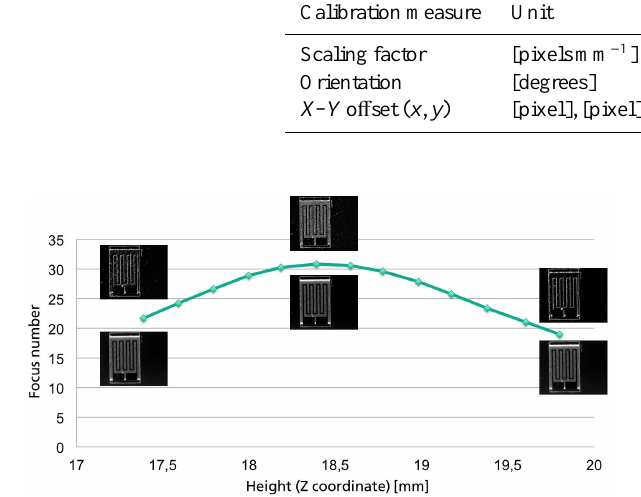
Figure 14. The plot shows a single measurement run determining the focus number calculated by the Tenengrad algorithm at a 0.2mm step size. For statistical analyses, the z coordinate of the surface has been determined 40 times by an autofocus algorithm.